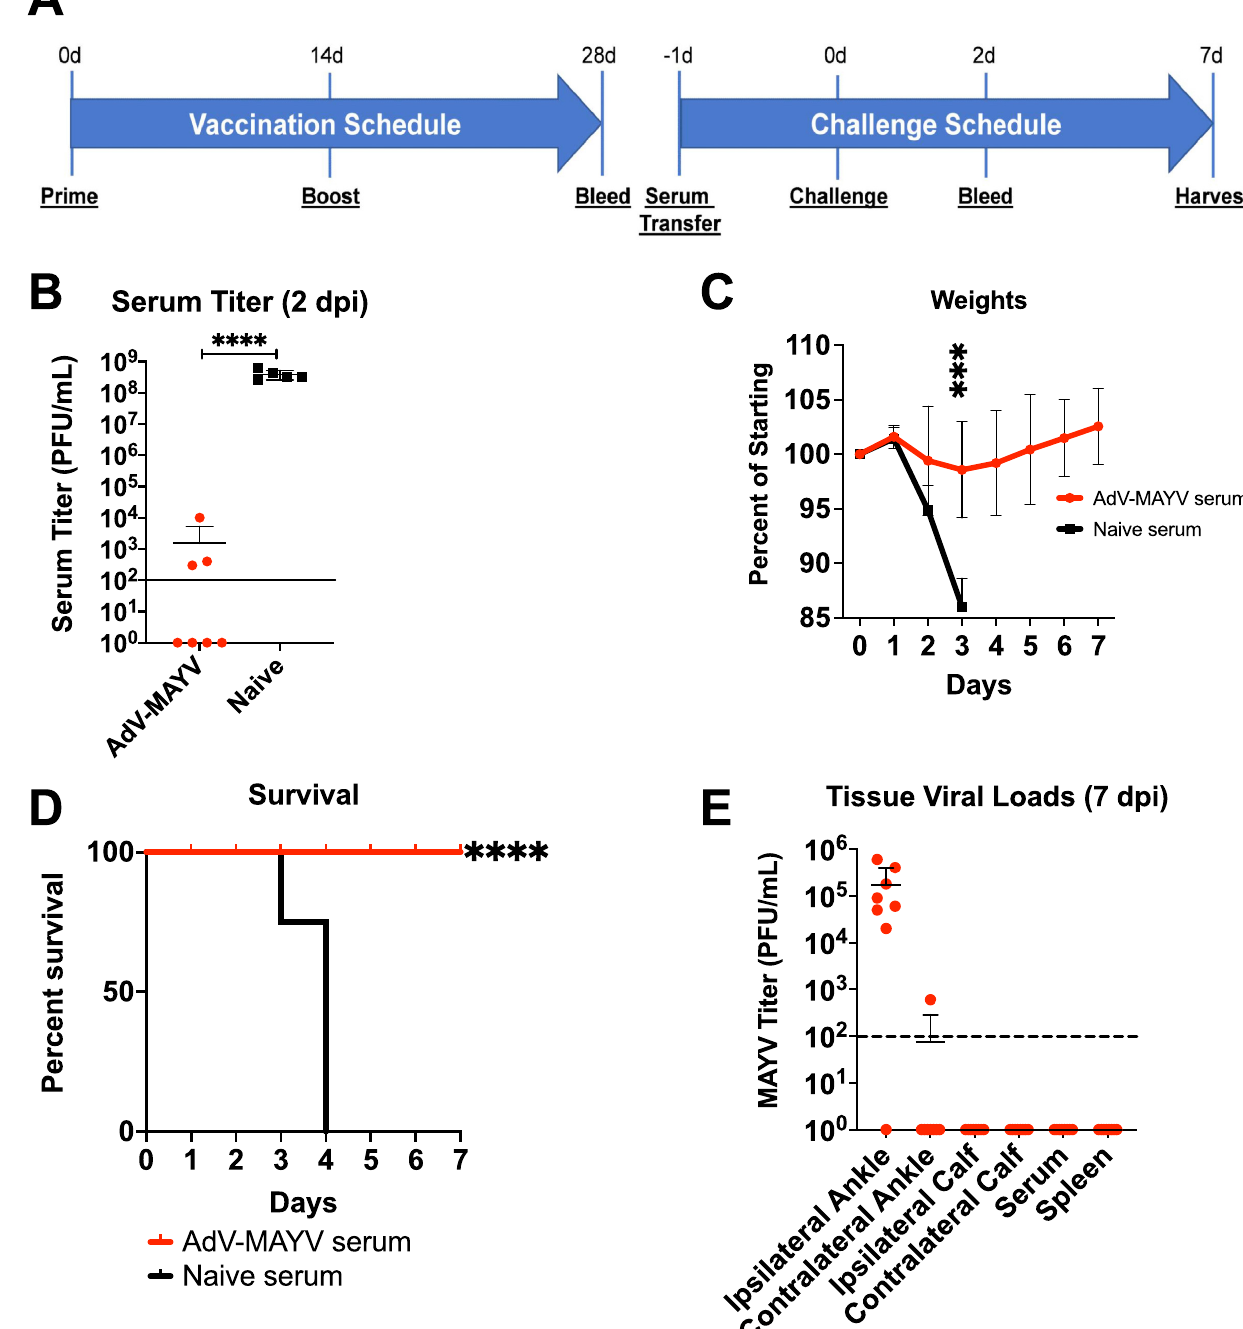
Fig 8. Passive Transfer of Immune Serum Protects IFN α R1 -/- Mice from Lethal MAYV Challenge. (A) Six WT C57BL/6N mice were vaccinated with 10 8 PFU of AdV-MAYV following the prime + boost regimen; at 28 days post-prime total blood was collected and serum pooled from all mice. A bolus of 200 μ l of pooled serum from AdV-MAYV vaccinated or naive mice was administered to IFN α R1 -/- mice by intraperitoneal injection 1 day before challenge with 1x10 4 PFU MAYV BeAr . The data represents one experiment with n = 7 per condition. (B) Blood collected at 2 days post-challenge was used to measure viremia by limiting dilution plaque assays. While all 7 animals receiving control serum had high levels of virus, only three of the seven animals receiving passive transfer of immune sera had detectable virus, which was 5–6 logs lower than controls. Statistical analysis was performed on log-transformed data using a Mann-Whitney test ( �� P < 0.005). (C) Mice were weighed daily after challenge until experiment endpoint at 7 dpi. Statistical analysis was performed using